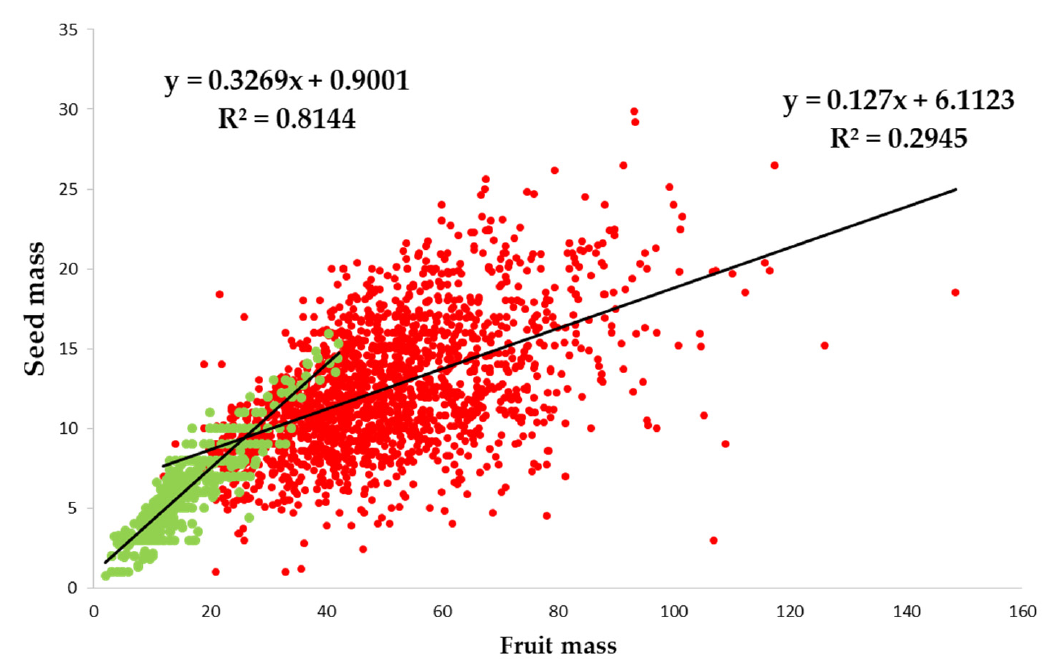
Figure 3. Correlation between fruit and seed mass for wild (in green) and cultivated (in red) individuals.